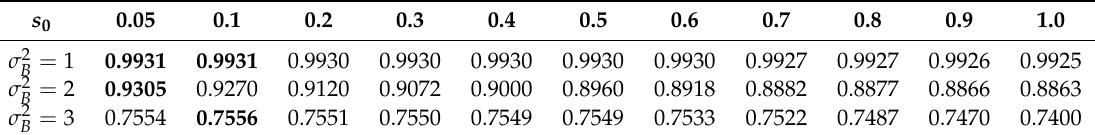
). The best SSIM B